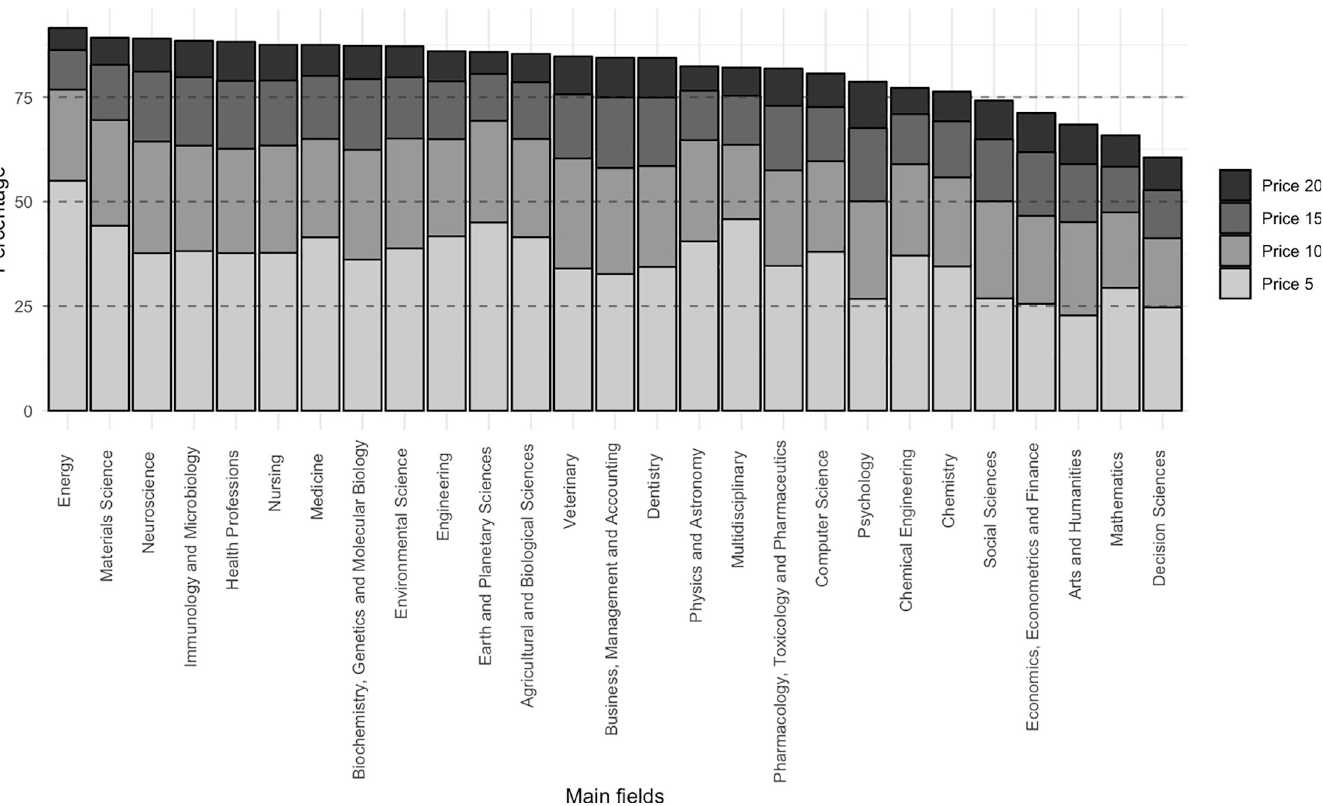
Fig 9. Price index for Wikipedia main fields.